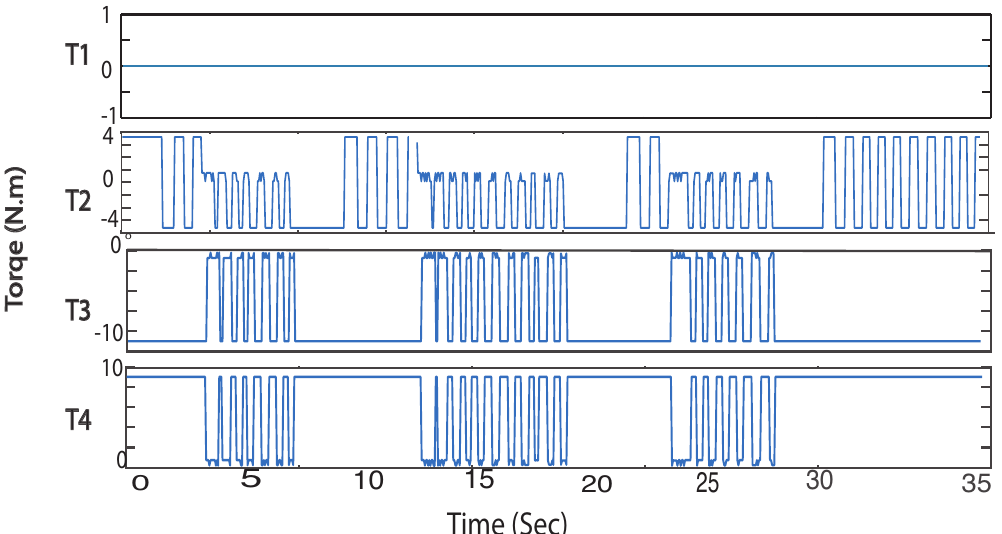
Figure 11. Simulation Results for State 2: Torque of motor 1,2,3,4 For state2.